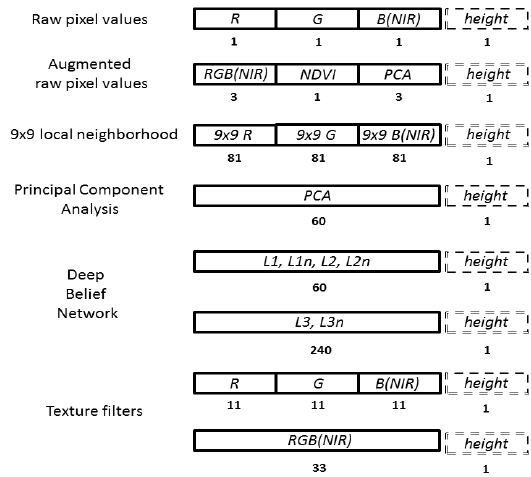
Figure 3. Feature vectors for each of the methods. The height information is used as an additional feature in the GRAZ dataset.